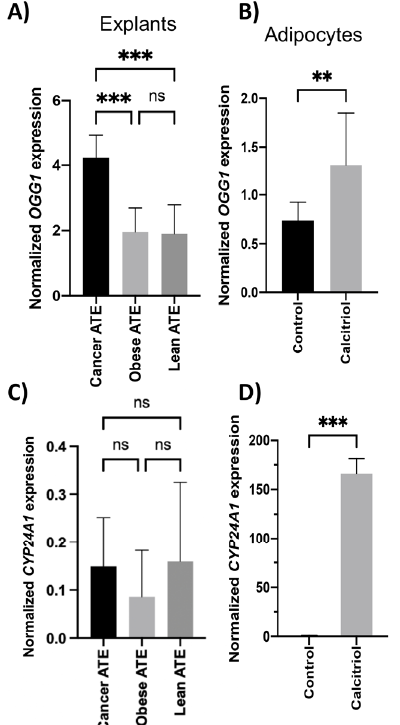
Figure 3. In vitro validation of the OGG1 gene profile in the adipose tissue and adipocytes: Total RNA from explants was extracted, and gene expression was measured. Normalized gene expression of ( A ) OGG1 and ( C ) CYP24A1 was calculated by comparing explants from healthy lean participants (N = 3), healthy obese participants (N = 3), and patients with CRC (N = 4). Adipocytes were treated with 0.5 µM of calcitriol for 24 h. ( B ) OGG1 and ( D ) CYP24A1 was calculated by comparing control and treated adipocytes. The asterisks indicate signi fi cant values according to the test (** p < 0.01; *** p < 0.001). Gene expression was normalized using the PPIA gene and the formula 2 −Δ Ct . ns: no sig- ni fi cant.